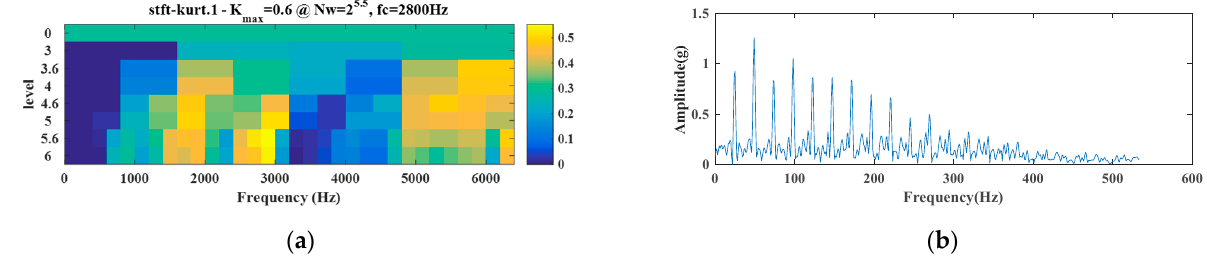
Figure 18. SK filtering result of experimental inner race fault signal: ( a ) kurtogram; ( b ) envelope spectrum of the filtered signal.